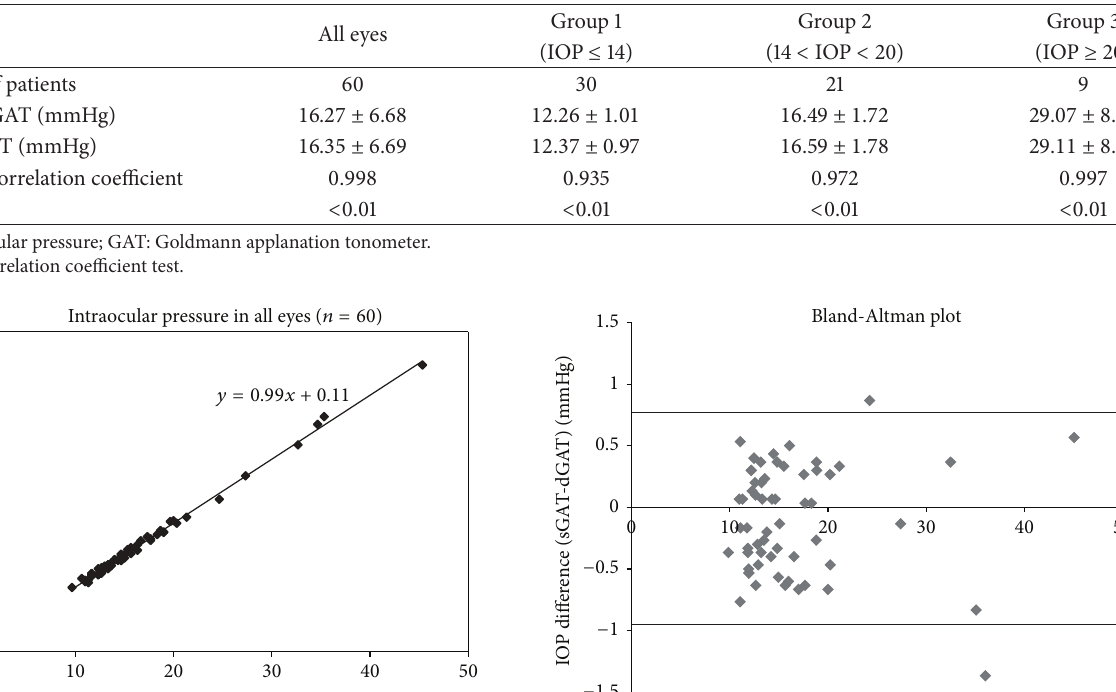
Table 2: Mean intraocular pressure readings in the study subjects.